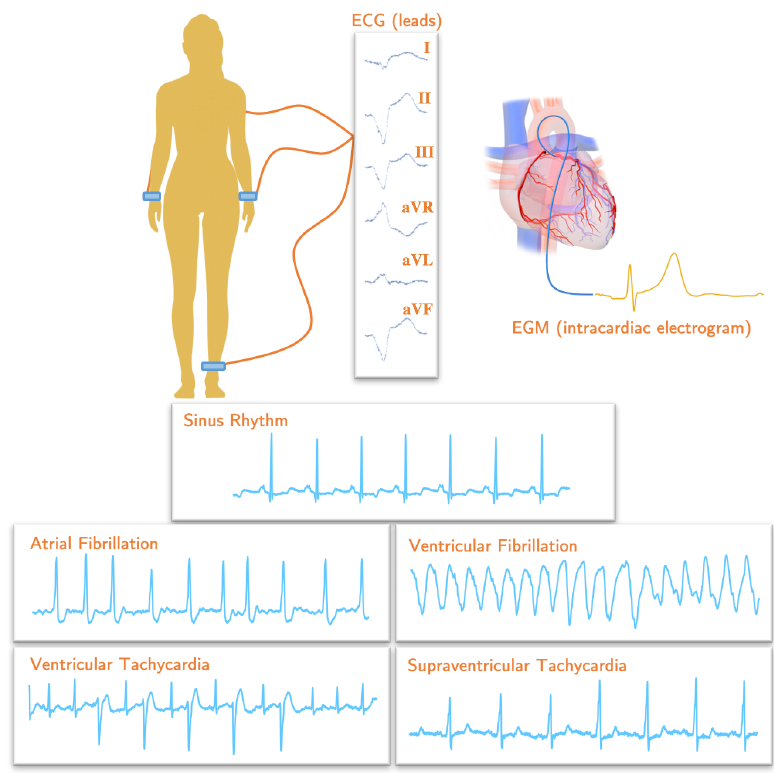
Figure 2. Representation of the placement of the ten electrodes in the 12-lead ECG configuration and the limb leads (I, II, III, aVR, aVL, and aVF), intracardiac electrogram signals, and ECG signals with normal (sinus rhythm) and non-normal